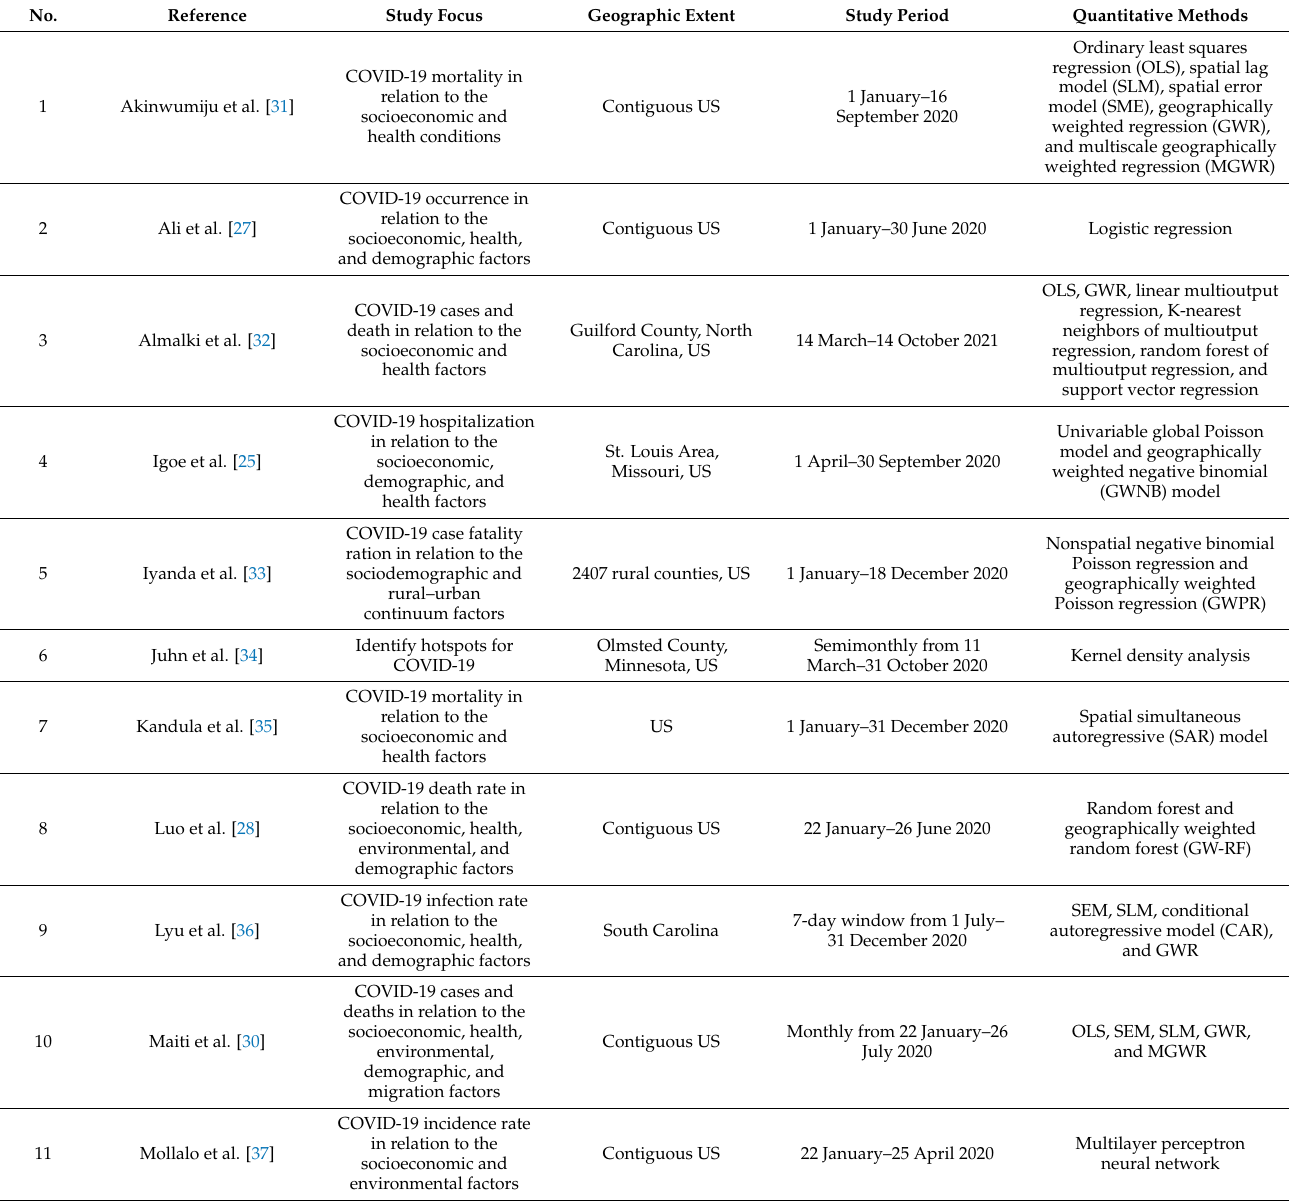
Table 1. Previous studies exploring COVID-19 and driving factors in